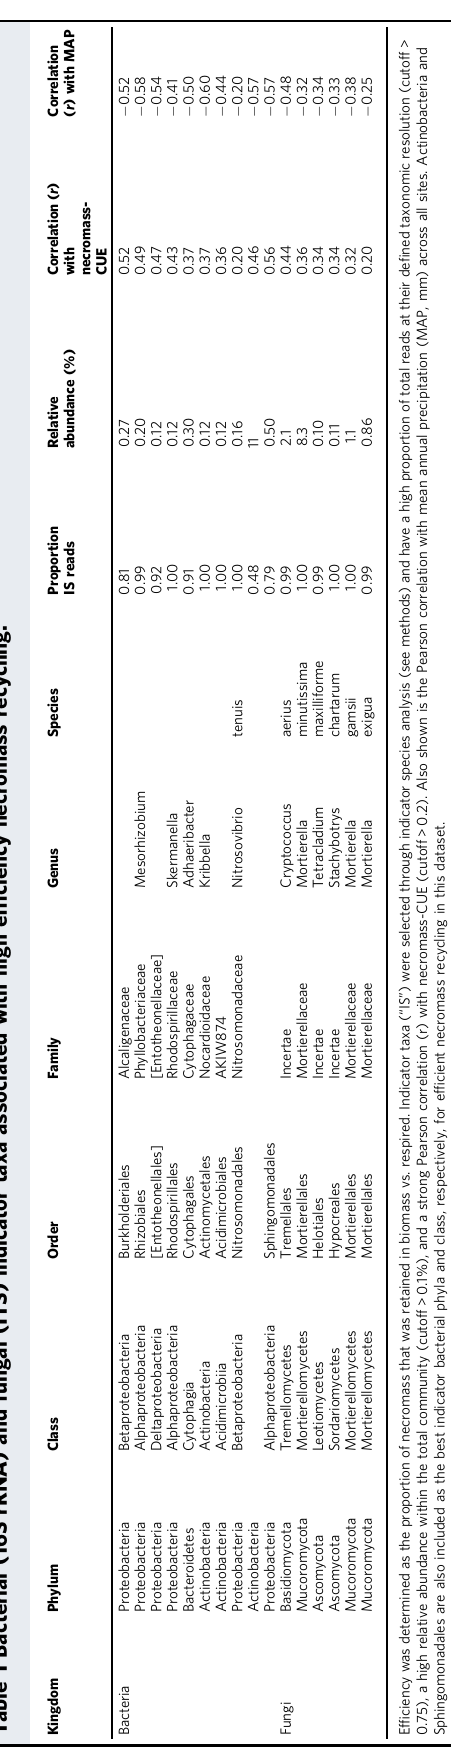
where MB δ 13 C fum is the δ 13 C value of the microbial biomass from the CHCl 3 - fumigated soil extract, C fum is the C pool size of the CHCl 3 -amended soil water